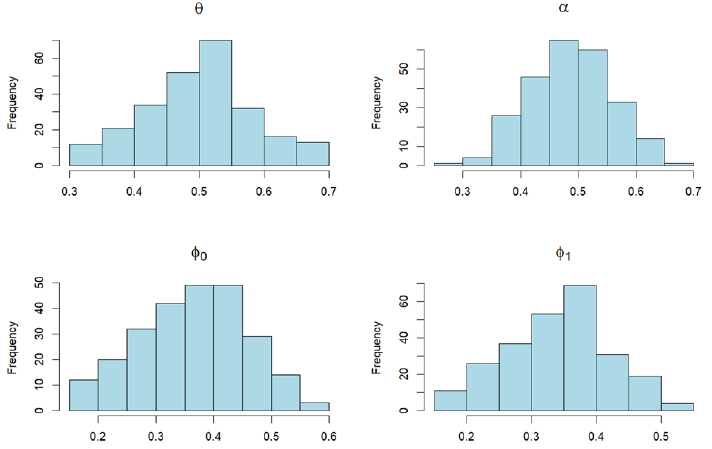
Figure 4. Histograms of empirical distributions of the estimated parameters of the ZOIPS-INAR(1) process with zero-and-one inflated geometric PS innovations. (Parameters are the same as in Table